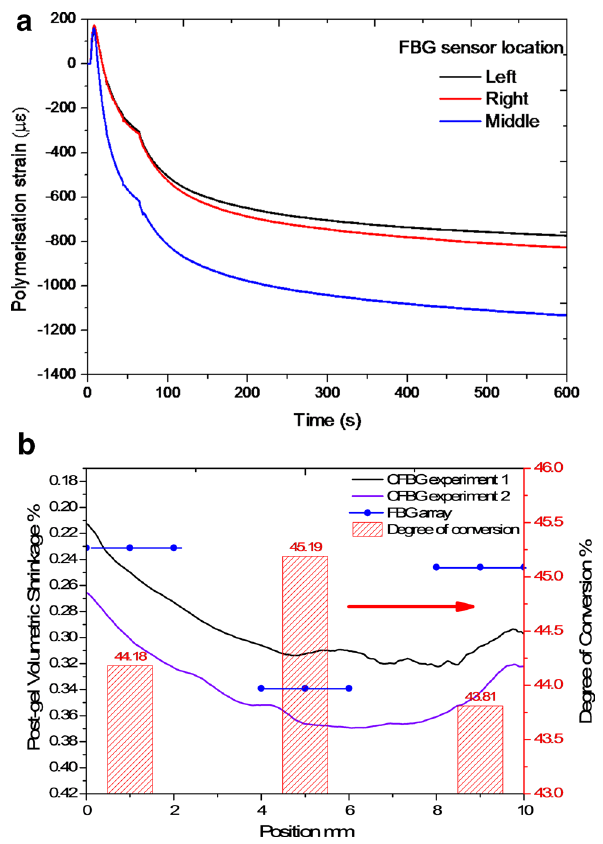
Figure 5. ( a ) PS strain response at three locations of the dental composite measured by the FBG array, ( b ) comparison of post-gel volumetric PS of the dental composite measured by CFBG sensor and FBG sensor